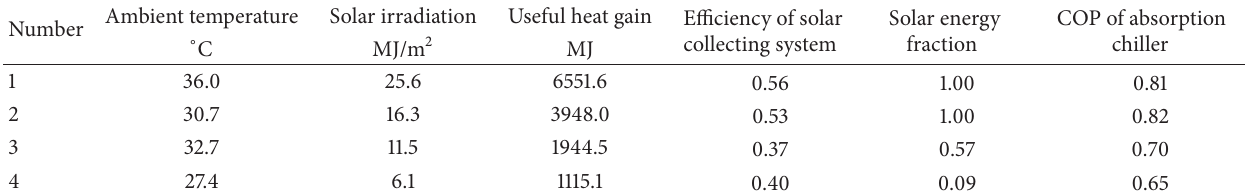
Table 13: Test results for a solar air-conditioning system during cooling conditions.